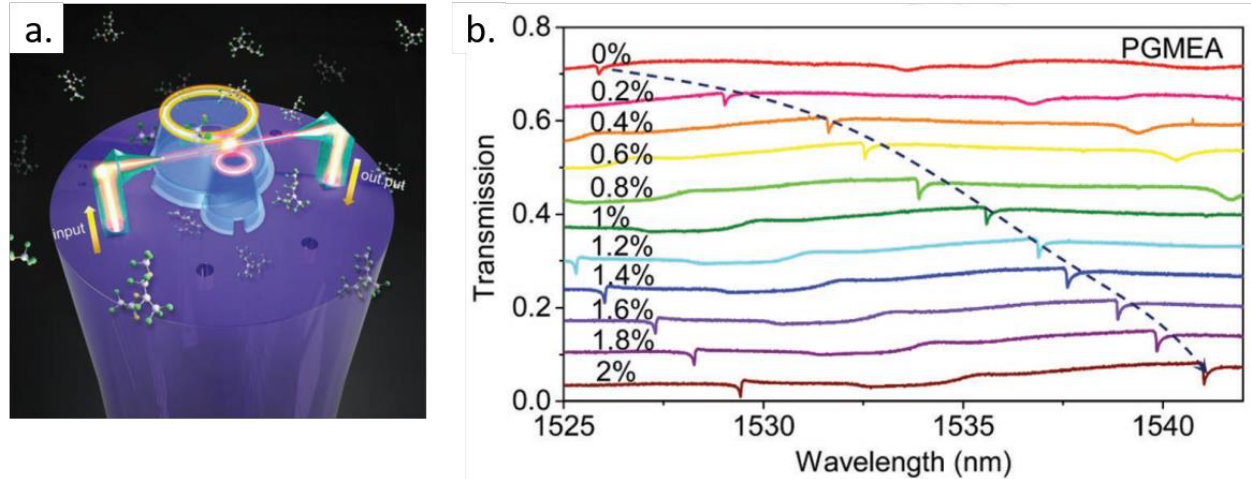
Figure 15. Microring resonators fabricated by TPP on the facet of a multicore optical fiber for vapor sensing. ( a ) Illustration of the light propagation in the photonic setup. ( b ) Spectral response of the microresonator when the fiber tip is placed in the vapor environment produced by an aqueous solution of propylene glycol monomethyl ether acetate (PGMEA) with the concentration varying from 0% to 2%, in steps of 0.2%. Adapted with permission [26]. Copyright © 2019, John Wiley and Sons.